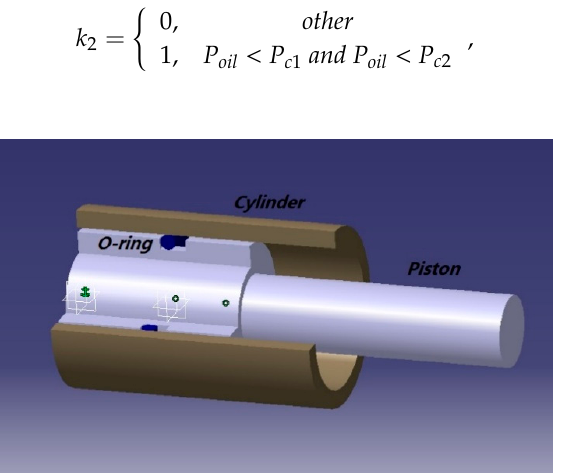
Figure 1. Geometry model of a rubber O-ring seal.